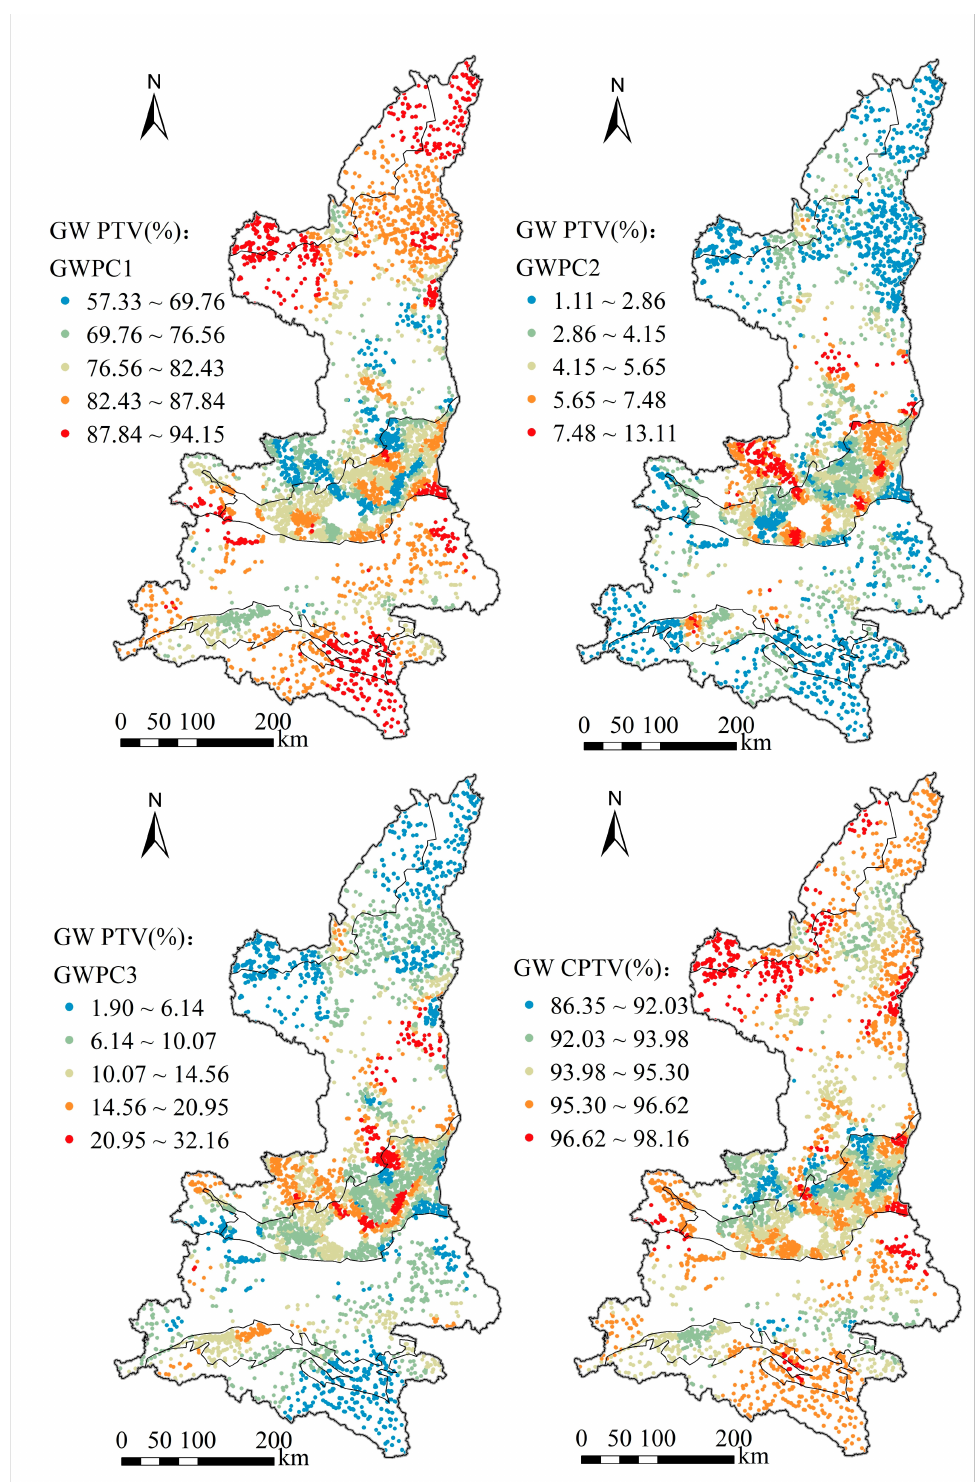
Figure 3. Maps of the PTV for GWPC1, GWPC2, GWPC3, and CPTV of the first three GWPCs. GWPC, geographically weighted principal component; PTV, percentages of total variation; CPTV, cumulative percentages of the total